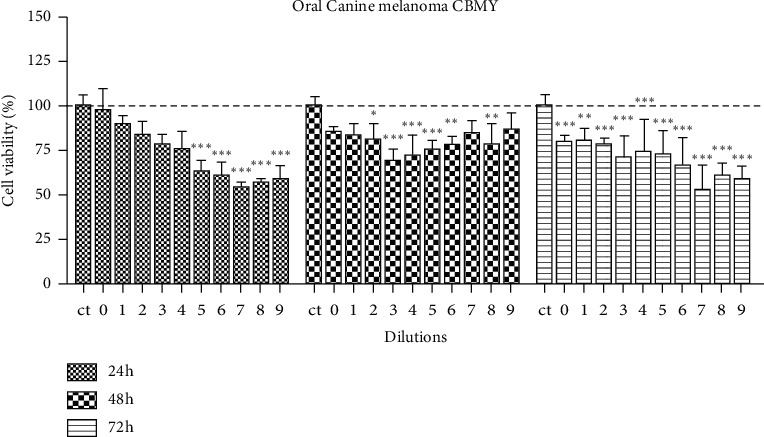
CBMY canine melanoma cell viability after treatment with different dilutions of E. tirucalli latex. The dilutions were numbered as follows: 0 (the E. tirucalli latex standard solution–1 mg/mL), 1(1/2), 2(1/4), 3(1/8), 4(1/16), 5(1/32), 6(1/64), 7(1/128), 8(1/256), and 9(1/512). The control group (ct) received 50 μl/well of saline solution. ∗p < 0.05,∗∗p < 0.01,∗∗∗p < 0.001.